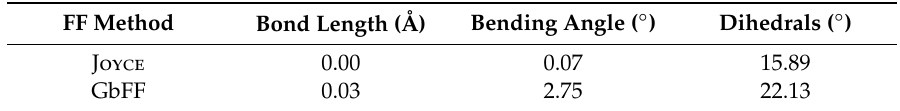
Table 2. RMSD values of the internal coordinates for the MM relaxed geometries with J oyce and GbFF methods, which are obtained by taking the DFT GS geometry as